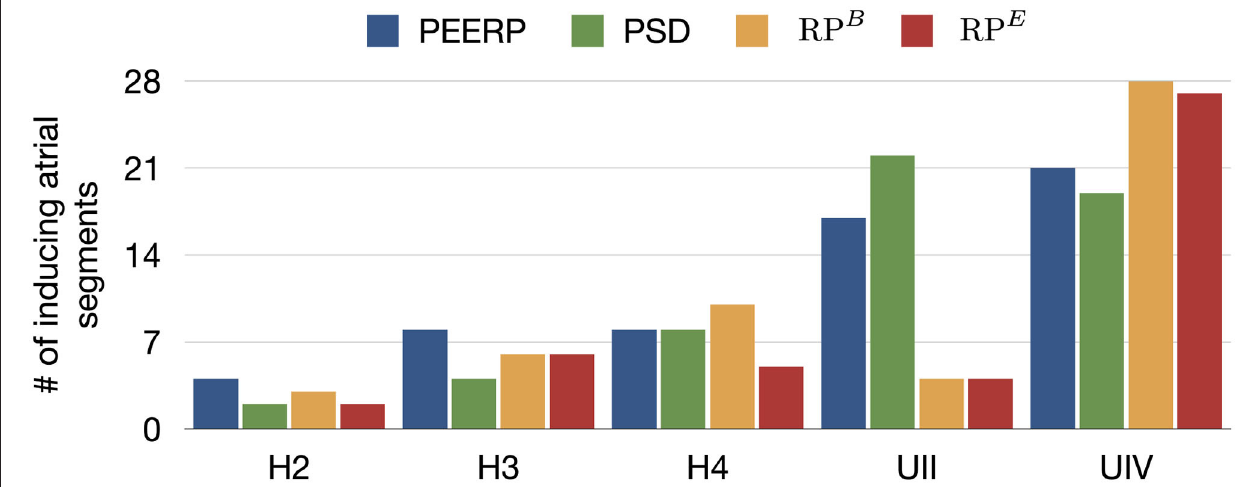
FIGURE 5 | Number of atrial segments in which inducing points were identified applying the various protocols in the different models.